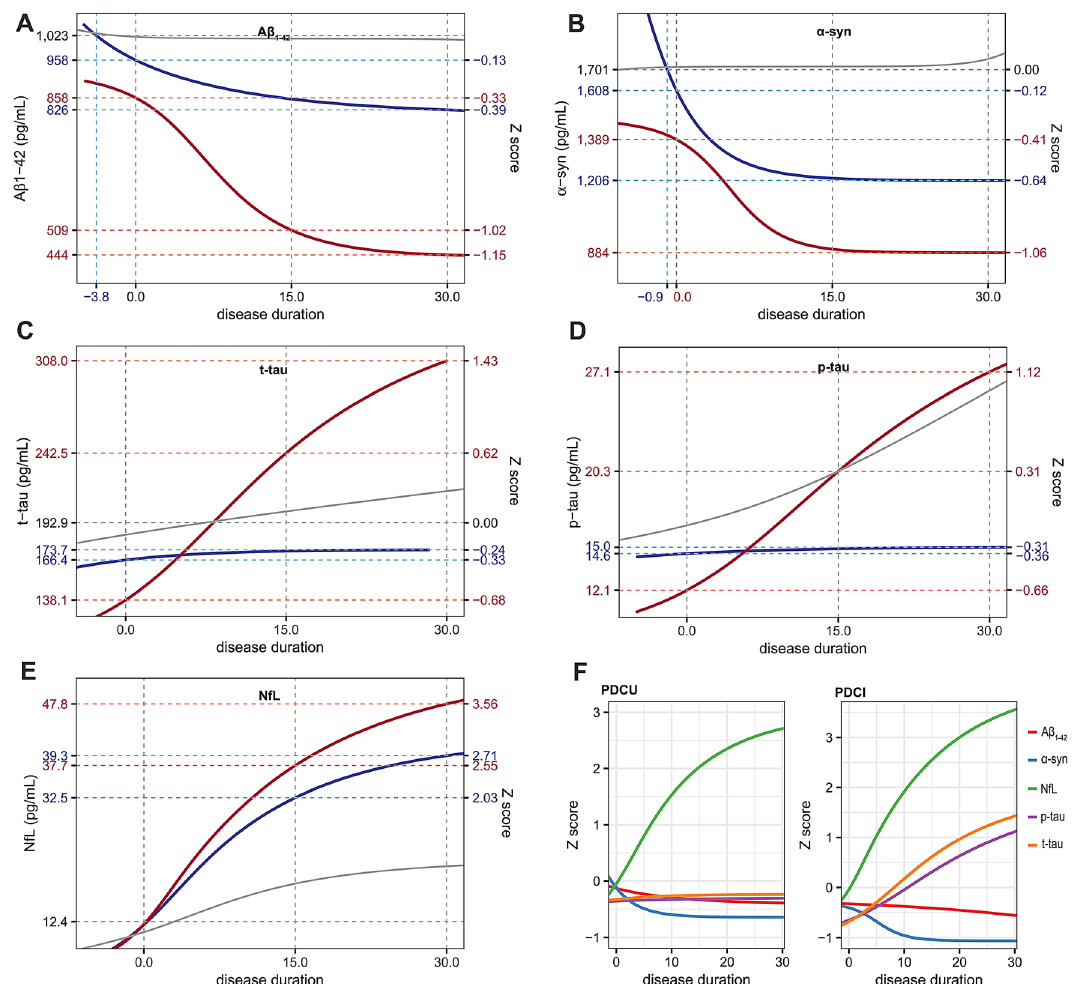
Figure 3. Temporal trajectories of biomarkers in PD patients with and without cognitive impairment at baseline. PD patients with cognitive impairment (red lines) show greater change in all five biomarkers ( A : Aβ 1-42 , B : α-syn, C : t-tau, D : p-tau, E : NfL) across the disease course than those without (blue lines). NfL showed the most remarkable changes both in PDCU and PDCI groups ( F ). Gray lines represent temporal trajectories